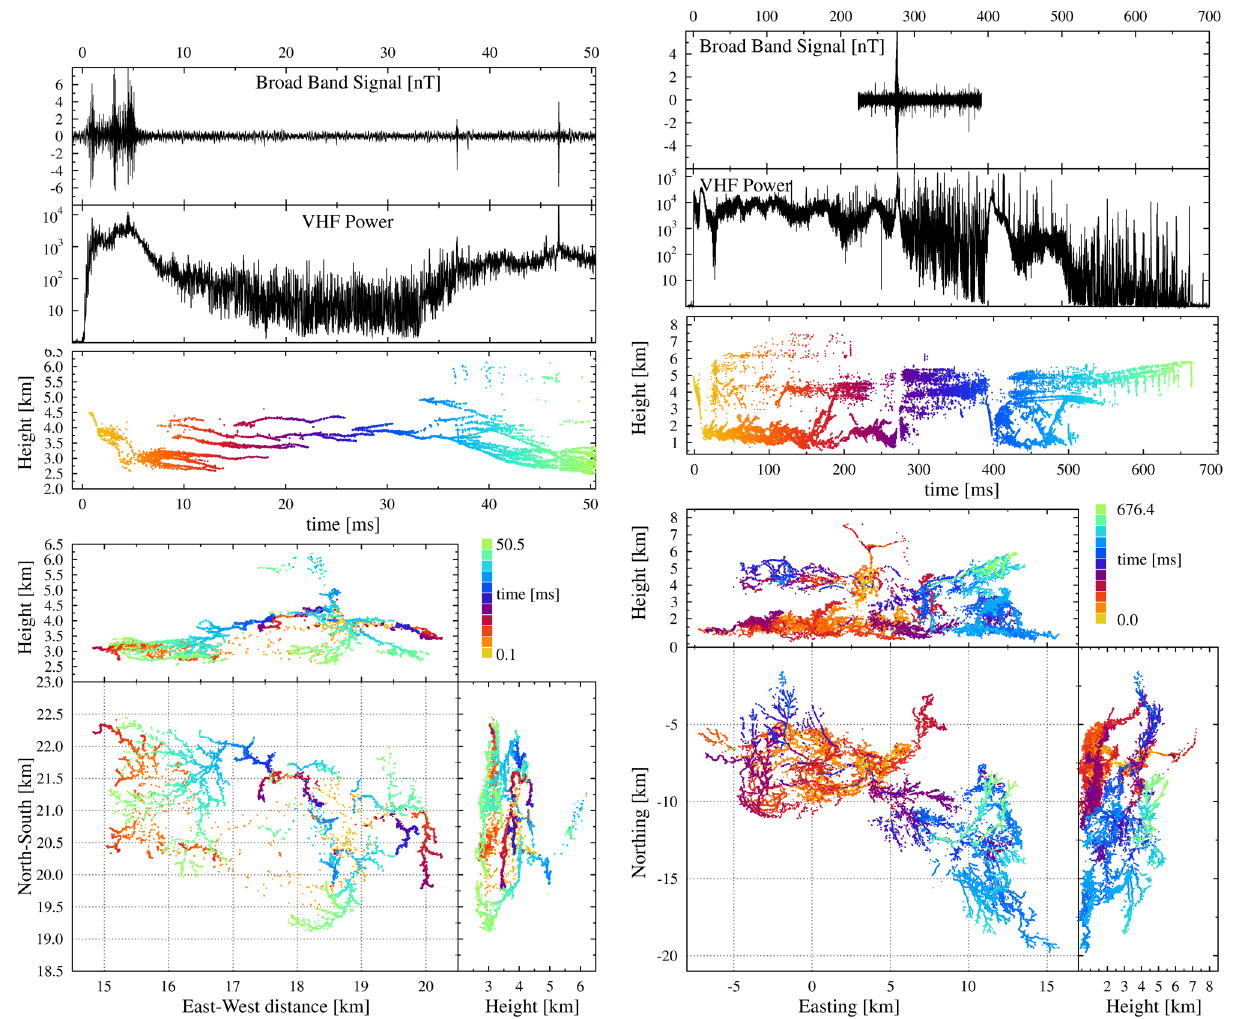
Figure 1. Left: Image of the first 50 ms of flash A showing sources with σ( h ) < 3.5 m, RMS d < 5 ns and N ex < 55 . The topmost panel shows the recorded signal in the broadband antenna, re-binned over 0.2 µ s. The second gives the VHF power as measured by a LOFAR antenna in the core, re-binned over 20 µ s. The LOFAR noise power is given in units of the background-noise, see text. Right: Image of flash B showing sources with σ( h ) < 3.5 m, RMS d < 3 ns and N ex < 55 upper of the two which is marked by the blue band). At t = 3 ms another surge in VHF power was detected as well as intense radio emission by the broadband antenna. The structures observed between t = 3 and 6 ms, intense radiation, fast propagation, diffuse distribution of sources with a multitude of emerging negative leaders, is a clear manifestation of a pair of leaders propagating in the IRNL mode. In Fig. 3 one of these is marked by the light-blue leader track (the track used to calculate the velocity follows the same leaders for both left and right sides where they are shown for different times). The velocity panel shows a clear peak of 1.5 the this negative leaders moved downward in the IRNL mode at t = 4 ms. The other negative leaders reached a similar speed at t = 3 ms in the IRNL mode. When the negative leaders in the INRL mode propagated downward at high velocity, strong pulses were seen in the broadband antenna, consistent with the fact that this antenna is exclusively sensitive to vertical polarization as emitted by a vertical current. Although the density of broadband pulses is large, most of them are initially positive bi-polar pulses which is indicative of negative charge moving down (due to polarization of the antenna). This is a clear signature of a downward moving negative stepped leader with a large current moment. After fanning-out, the IRNL transitioned into a second batch of normal negative leaders at around t = 6 ms that then gradually slowed down to a typical propagation velocity of a negative leader of about 10 panel on the right of Fig. 3, the velocity of one such negative leader (as indicated by the blue band in the lower panels of Fig. 3) is given. A large number of negative leaders were all propagating simultaneously in an area of 1 2 km. After t = 6 ms, the time trace of the broadband antenna is rather feature-less while the average power × in the VHF antenna gradually decreases by about 1 order of magnitude over the period t = 5.5–7.5 ms. At t =